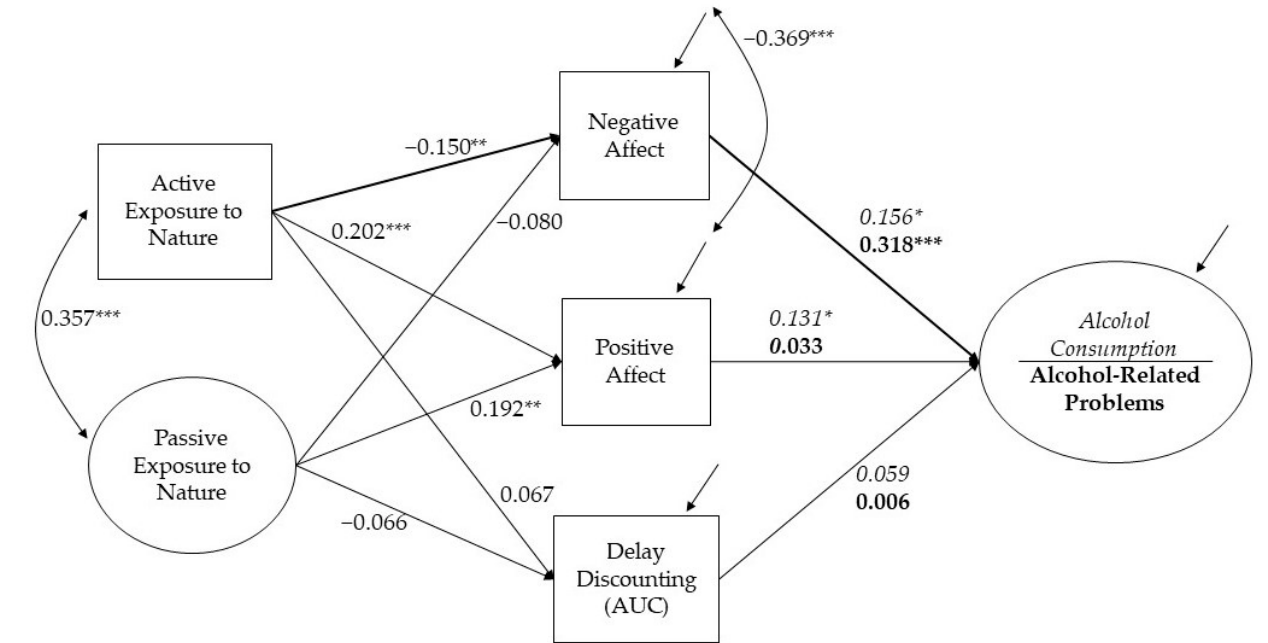
Figure 2. The relationships among nature, affect, delay discounting, and alcohol, controlling for age, gender, and income. All coefficients are standardized estimates with * p < 0.05; ** p < 0.01; *** p < 0.001. The estimates in regular font are identical in both models, the italic font is unique for Model 1 (Alcohol Consumption), and the bolded font is unique for Model 2 (Alcohol-Related Problems). Bolded arrows represent the significant mediated effect of active exposure to nature on alcohol-related problems. Nonsignificant correlations among the residuals of positive affect, negative affect, and delay discounting were not reported for simplicity.